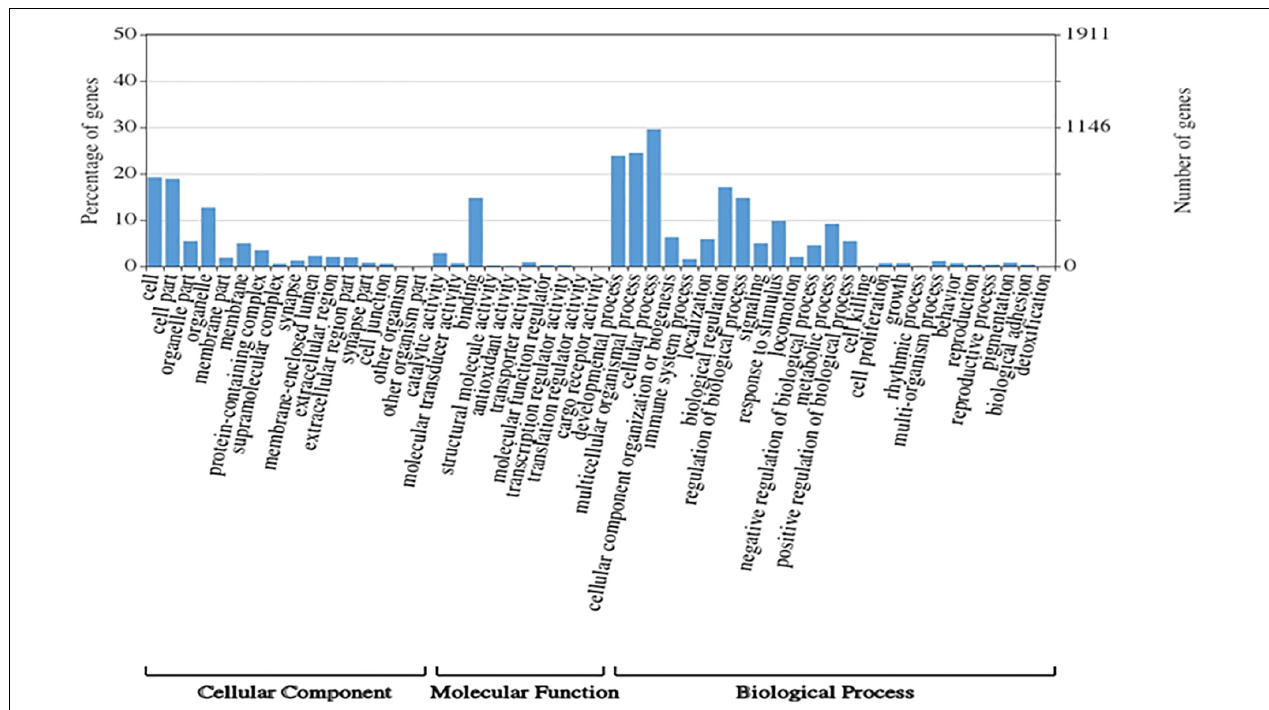
FIGURE 2 | Histogram of GO enrichment classifications (in level 2) of Patagonian toothfish genes. The results are summarized for three main domain components: cell component, molecular function, and biological process.